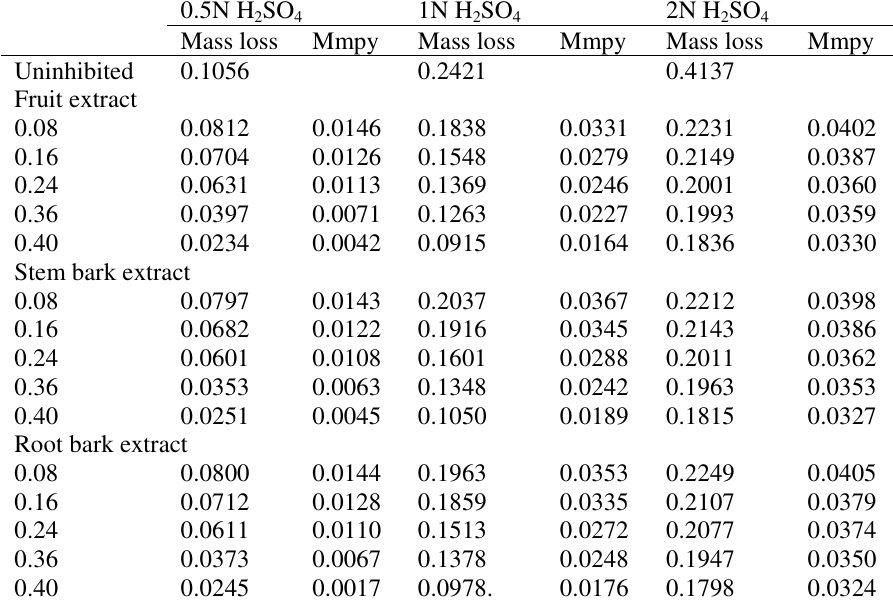
Table 2 . Mass loss and corrosion rate (Mmpy) for aluminium in sulphuric acid solution with given inhibitor addition at room temperature for Capparis decidua.